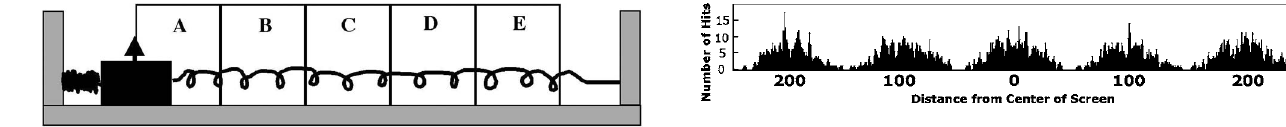
FIG. 3. Harmonic oscillator system. An air glider is attached by springs. The region of oscillation is split into five bins.